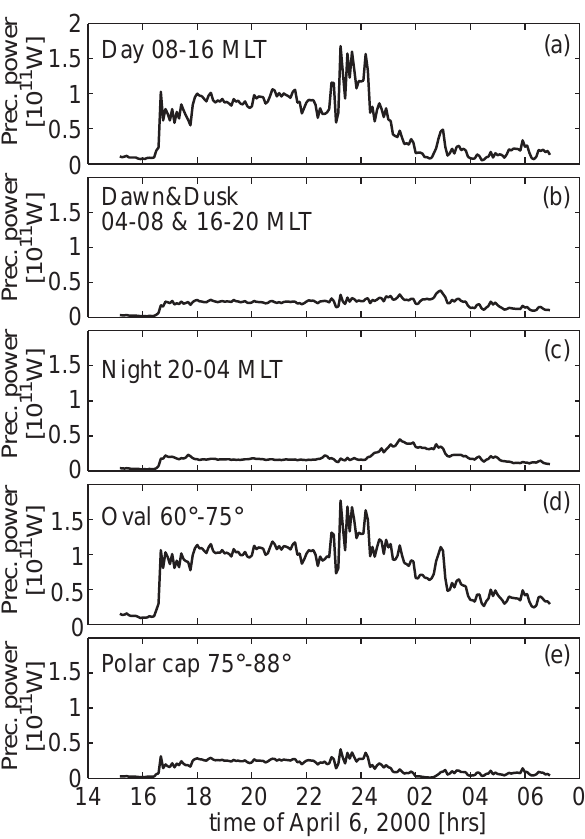
Fig. 12. Precipitation power during the 15 August 2001 substorm in the (a) dayside 08:00–16:00 MLT, (b) dawn 04:00–08:00 MLT and dusk 16:00–20:00 MLT, (c) nightside 20:00–04:00 MLT, (d) oval latitudes 60 ◦ –75 ◦ , and (e) polar cap latitudes 75 ◦ –88 ◦ . Both hemispheres are present in